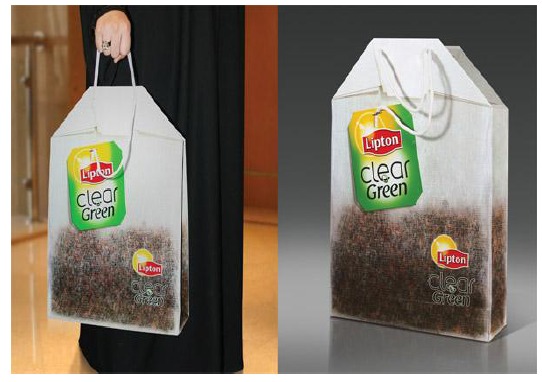
Figure 5. Lipton Tea